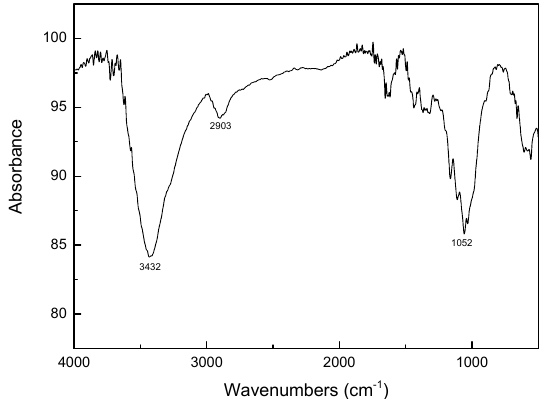
Figure 2. FT-IR spectra of CNC/GM sol mixtures containing 2 wt % of GM.